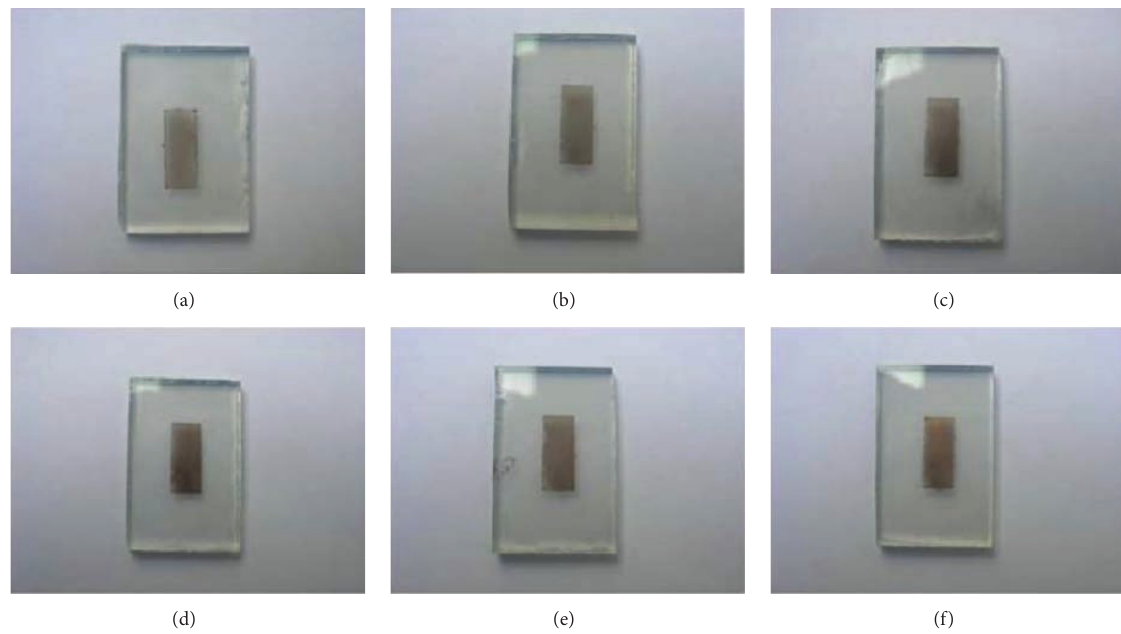
Figure 1: The TiO 2 /Ag composite films with varied UV exposure time as 5, 30, 60, 120, 180, and 240 min, corresponding to the silver nanoparticle sizes of (a) 4.4 nm, (b) 7.2 nm, (c) 11nm, (d) 19.2 nm, (e) 27.5 nm, and (f) 38.6 nm, respectively [4, 5].